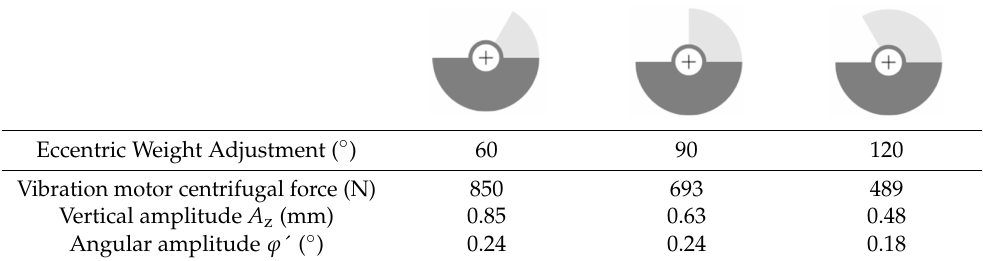
Table 1. Vertical and angular amplitudes values for vibration motors revolutions of n = 1800